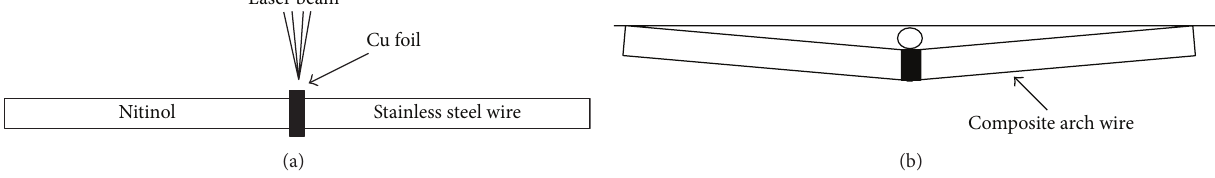
Figure 1: (a) Schematic diagram of laser welding; (b) device for applying 3-point bending forces to composite arch wire.